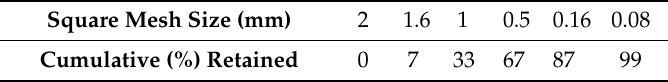
Table 1. The Grading of Standard CEN Sand.